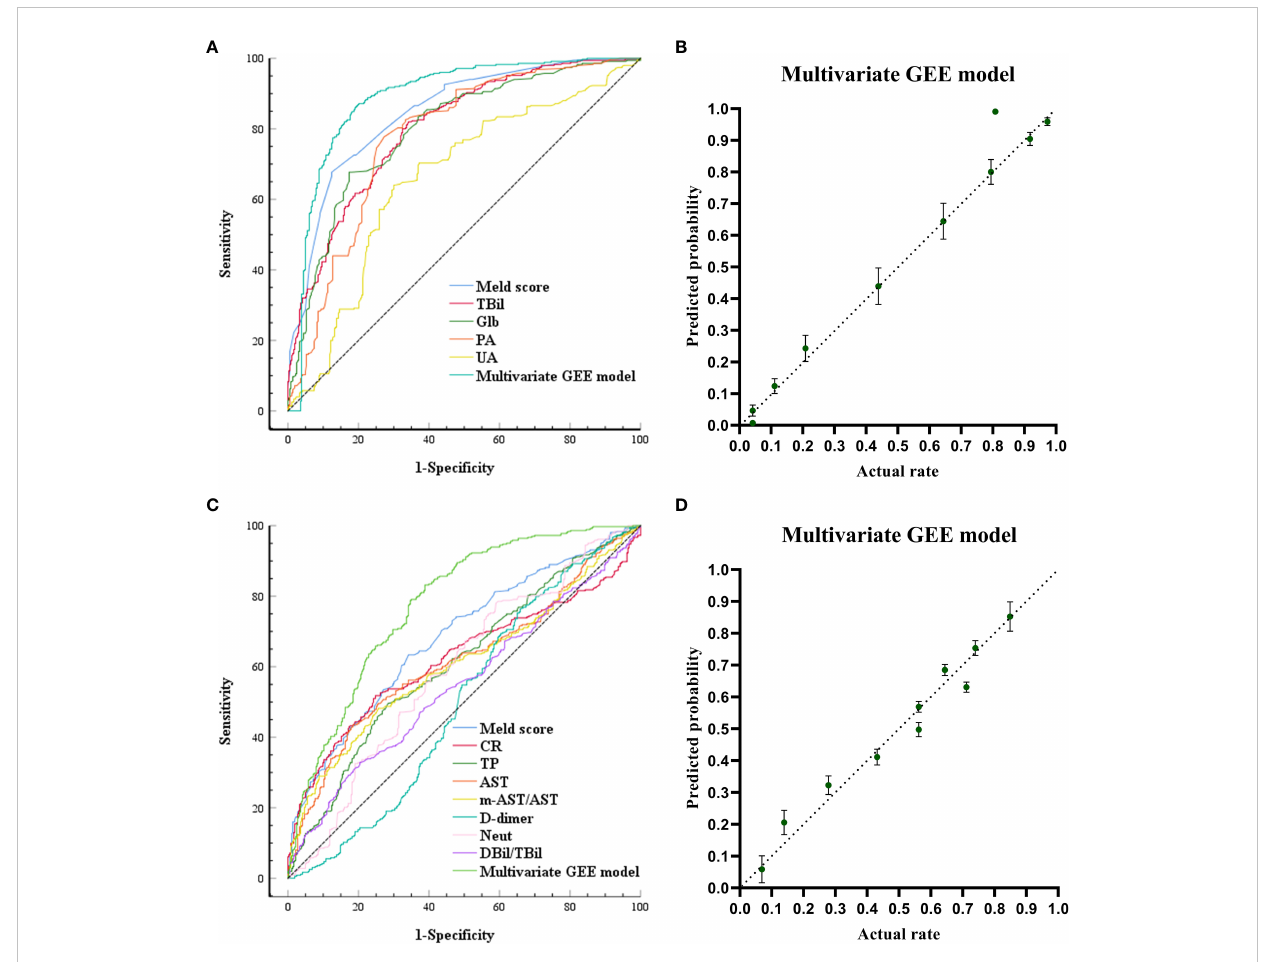
FIGURE 2 Receiving Operating Characteristic Curve and calibration plots for the post-models (models built after ALSS treatment) and change-models (models built by calculating the rate of change of each laboratory biomarker before and after ALSS treatment: Rate of change = (Post-ALSS-Pre-ALSS)/Pre- ALSS) to predict in-hospital outcomes. (A) ROC curve analyses for the capability of Meld, TB, globulin, PA, UA after ALSS and the multivariate generalized estimating equation (GEE) model to predict in-hospital outcomes. (B) Calibration plots for the post-multivariate models to predict in- hospital outcomes. (C) ROC curve analyses for the capability of change ratio of Meld, CR, TP, AST, m-AST/AST, D-dimer, NEUT, DBIL/TBIL and the multivariate generalized estimating equation (GEE) model to predict in-hospital outcomes. (D) Calibration plots for the change-multivariate models to predict in-hospital